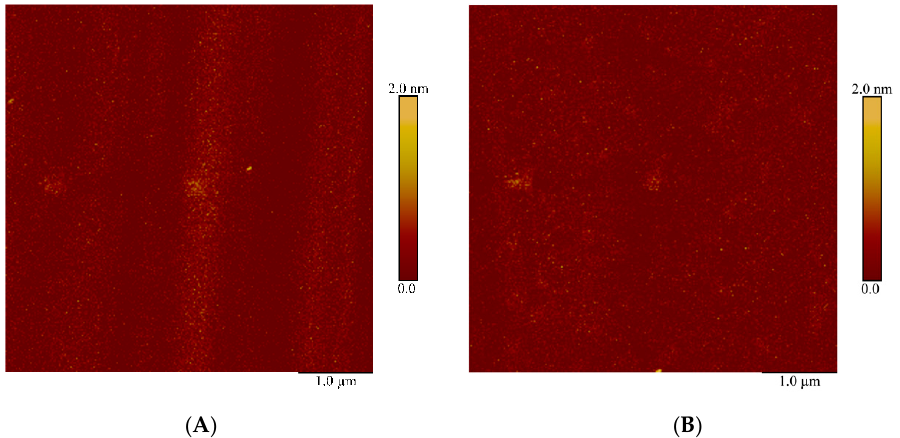
Figure 5. Typical AFM images obtained after incubation of DSP-activated ( A ) and non-activated ( B ) APTES-modified mica in 10 − 9 M HSA solution.